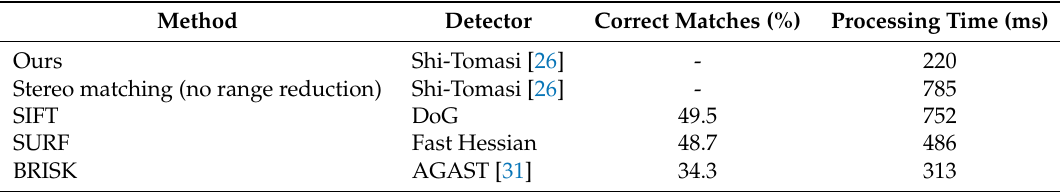
Table 1. Performance of used feature matching methods regarding processing time and correct